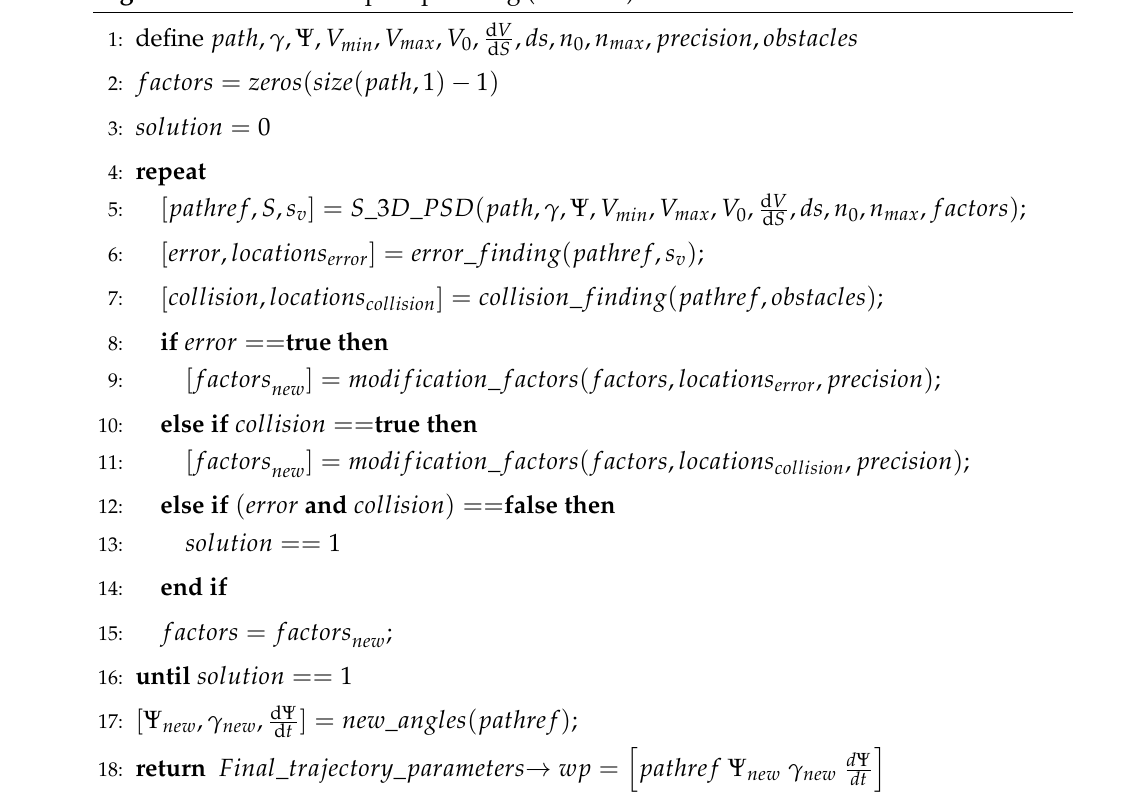
Algorithm 4 Smooth 3D path planning